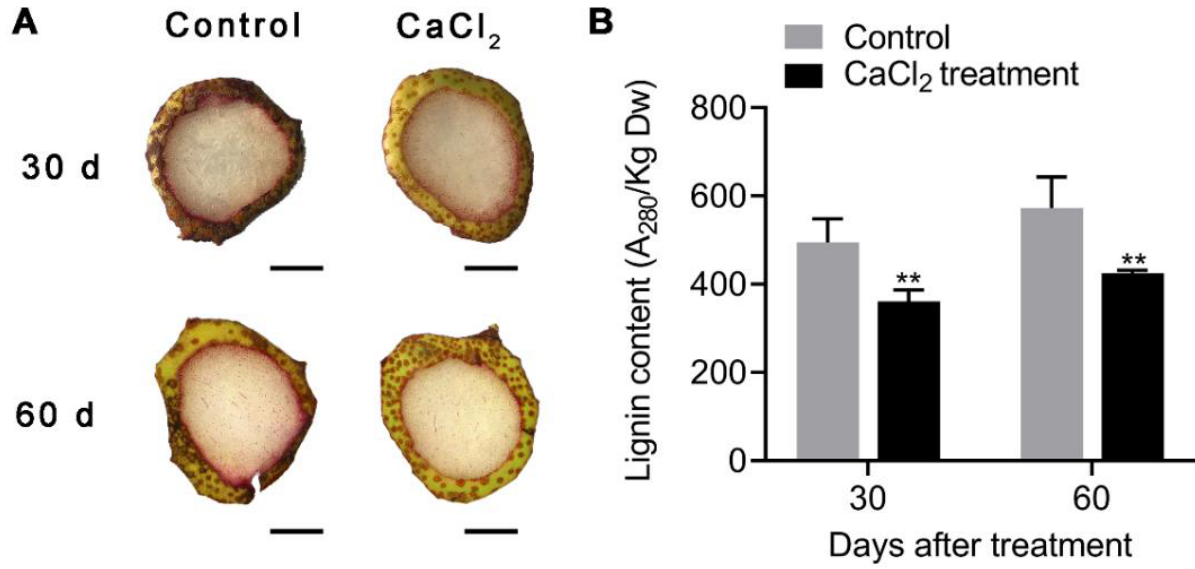
Figure 2. Effect of CaCl 2 treatment on lignin accumulation in pear pulp. ( A ) Transverse sections of the pulp were stained with phloroglucinol-HCl for the detection of lignin at 30 and 60 d after treatment. Scale bar = 2 cm. ( B ) The lignin content of fruit at 30 and 60 d after treatment. Data are given as mean ± SD (n = 3).